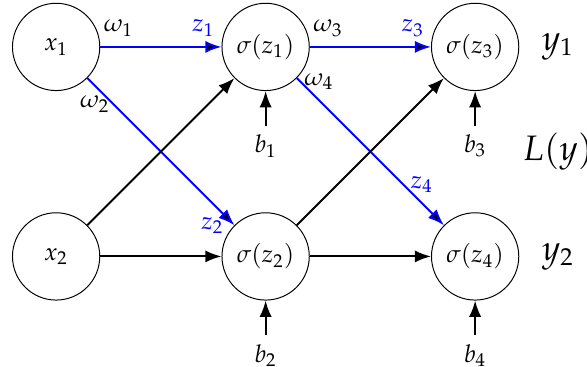
Figure 4. Graphical illustration of back-propagation with a three-layer fully connected neural network as an example. x = [ x 1 , x 2 ] are the inputs, and y = [ y 1 , y 2 ] are the outputs. ω = [ ω 1 , ω 2 , . . . ] are the weights, and b = [ b 1 , b 2 , b 3 , b 4 ] are the biases. L ( y ) is the loss function. z = [ z 1 , z 2 , z 3 , z 4 ] are the intermediate neuron inputs, for example z 3 = ω 3 activation function. Normally, the gradients are calculated from the last to the first layer. For example, according to the chain rule, ∂ L ( y ) function, and it is easy to find that ∂ y 1 (The path is highlighted in